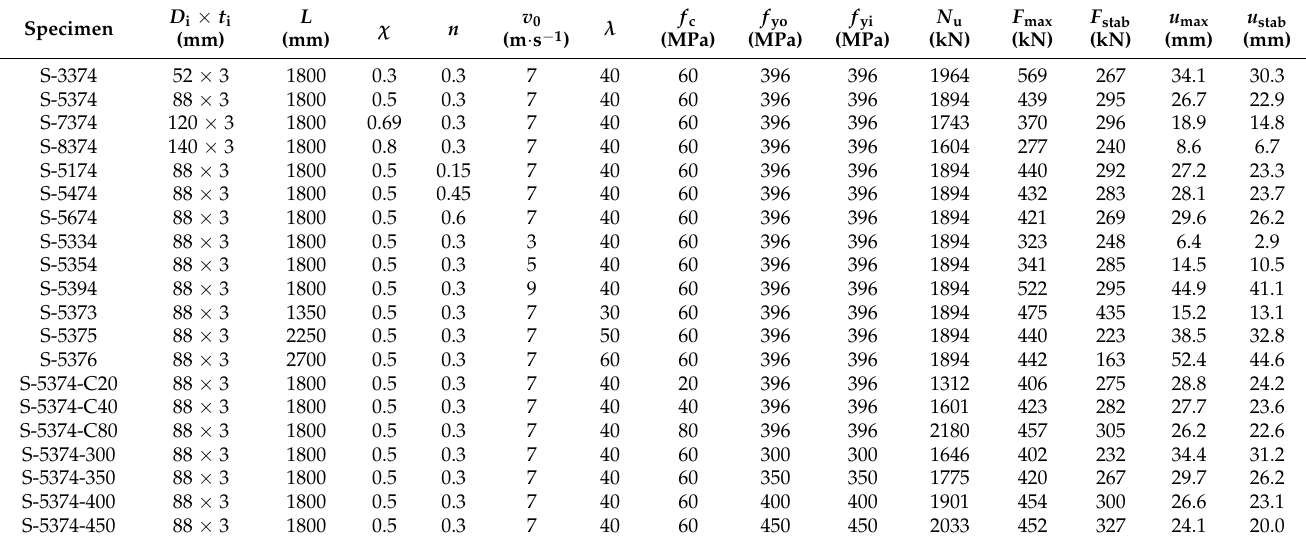
Table 5. Specimens and